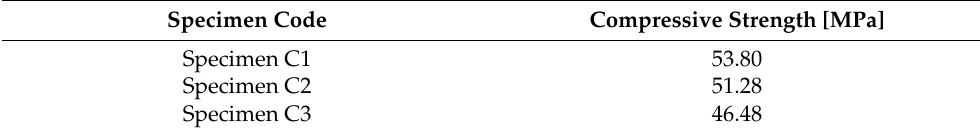
Table 4. Compressive strength results at 28 days.